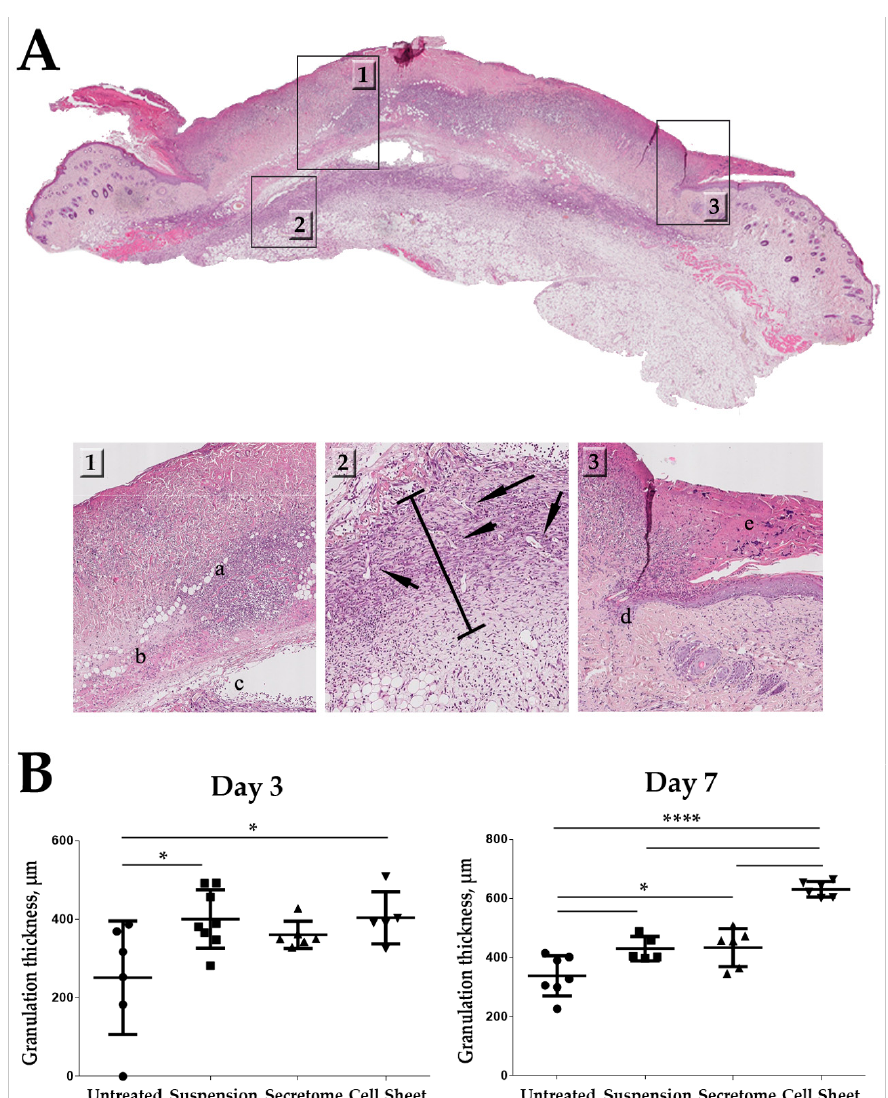
Figure 4. Influence of cell sheets, suspended MSC or MSC secretome on GT thickness in healing of pressure ulcer. ( A ) Representative image of a histological section at Day 3; panel markup: 1 —zone of damaged tissue down to ( a ) muscular layer with ( b ) immune cells infiltration and ( c ) edema of underlying tissue; 2 —zone of GT formation; bar indicates measured thickness, arrows indicate blood vessels; 3 —defect surface with ( e ) scab and ( d ) margin of migrating epithelial layer covering ulcer. Hematoxylin-eosin staining, scale bar represents 50 µm; ( B ) quantitative results of GT thickness analysis at Days 3 and 7; (*— p < 0.05; ****— p < 0.0001).